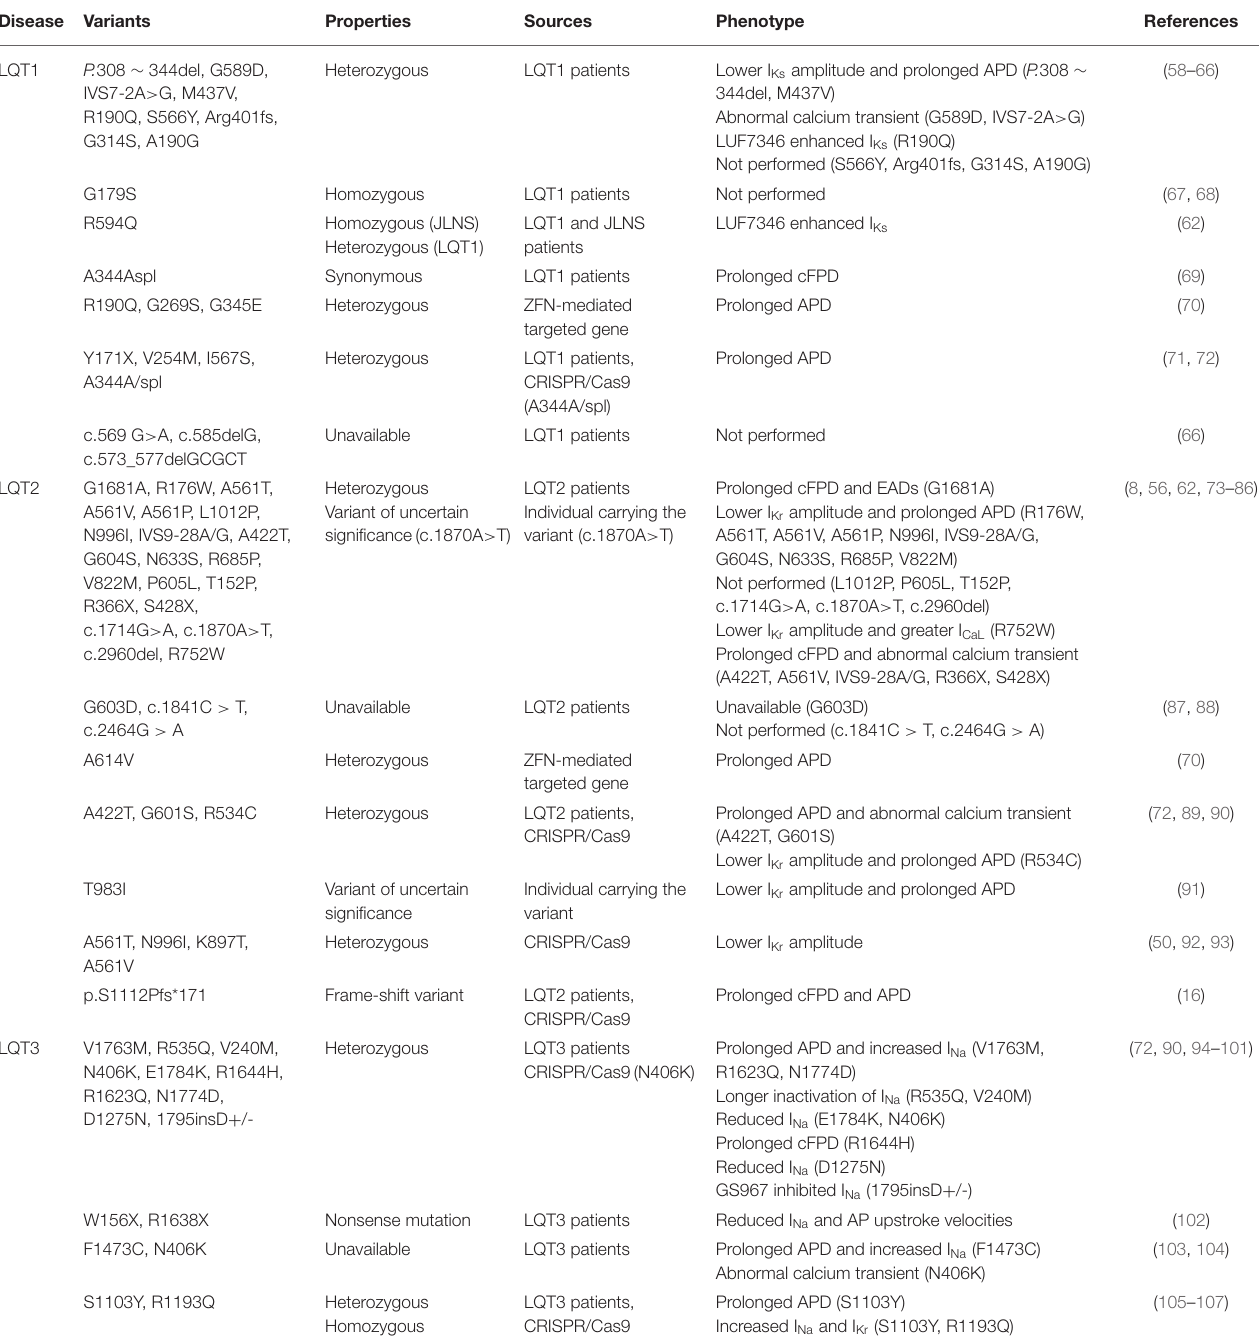
TABLE 1 | Disease-specific and CRISPR/Cas9-edited LQTS-associated variants characterized in